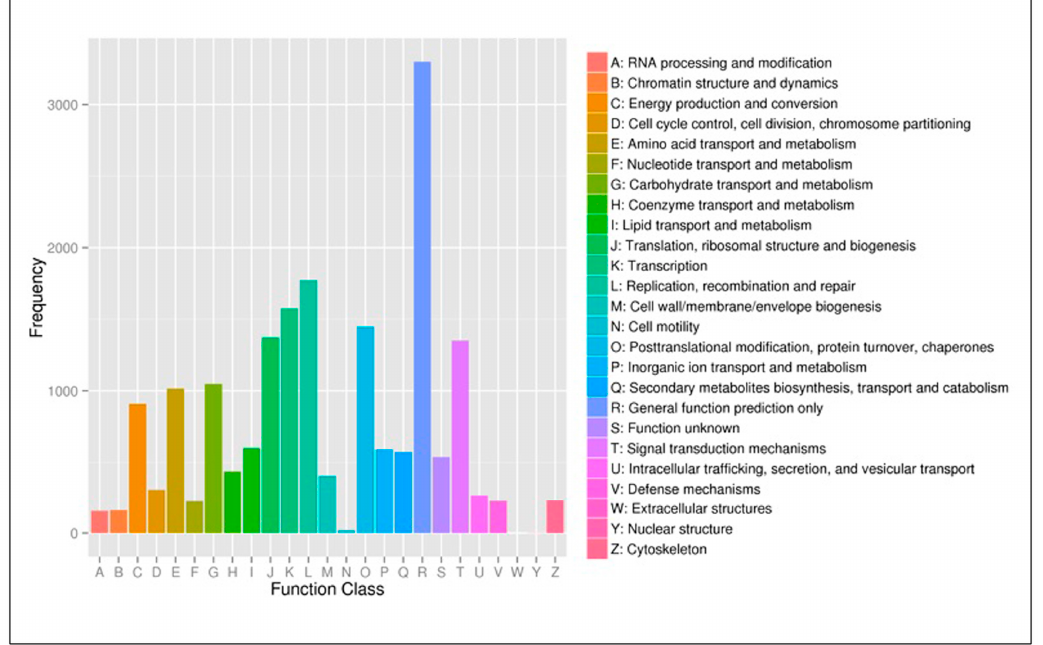
Figure 6. COG Function Classification of Consensus Sequence.